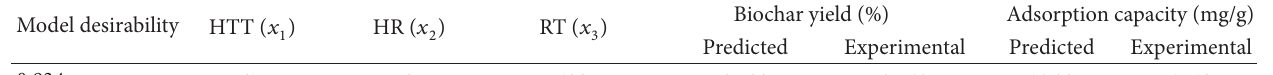
Table 5: Model validation.